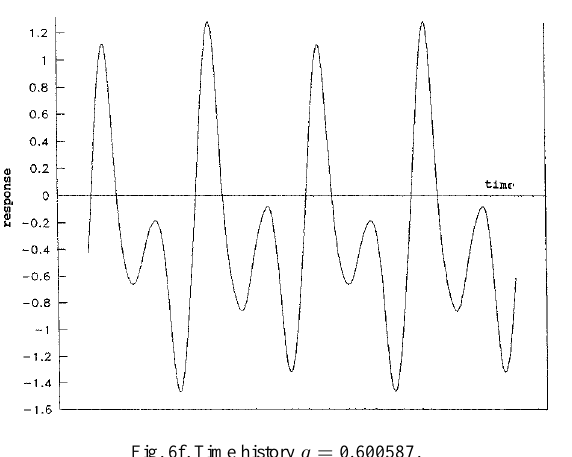
Fig. 6f. Time history q = 0 : 600587.